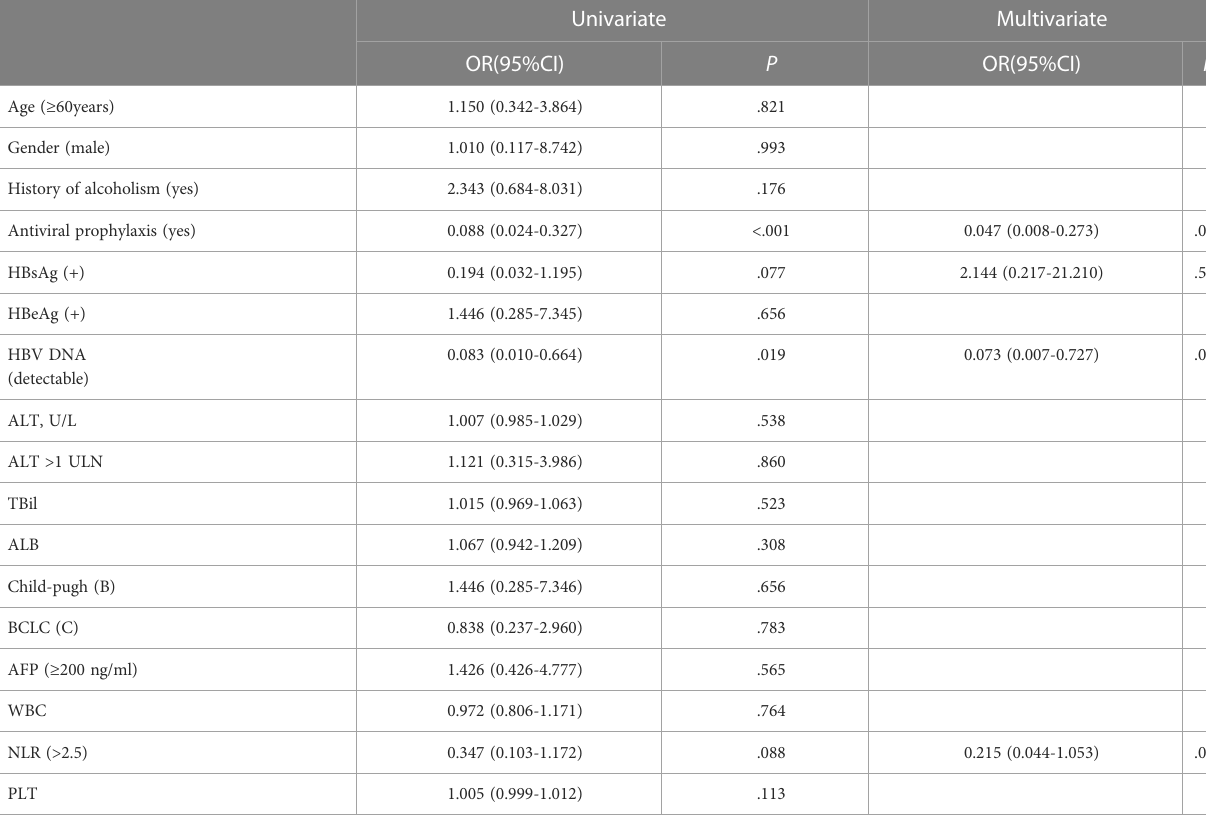
TABLE 4 Univariate and multivariate logistic regression analysis for risk factors of HBV